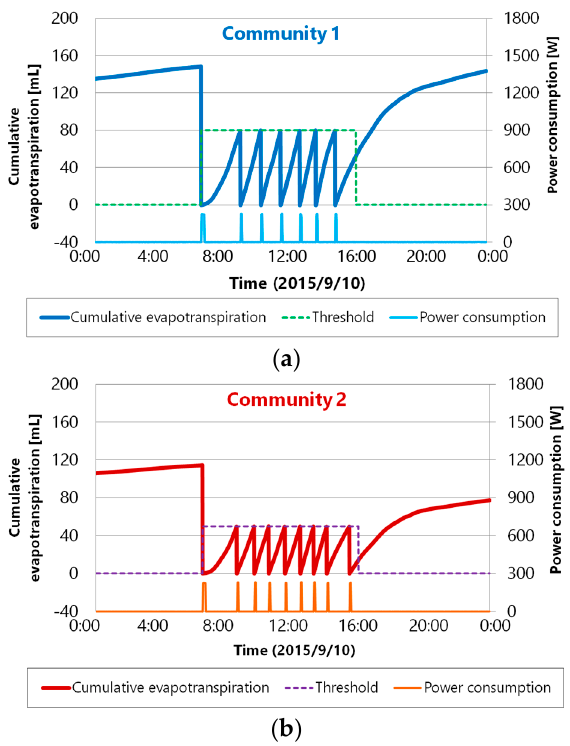
Figure 13. Result of hydroponic liquid control ( a ) community 1; ( b ) community 2. Table 3. Control settings of each tomato community.